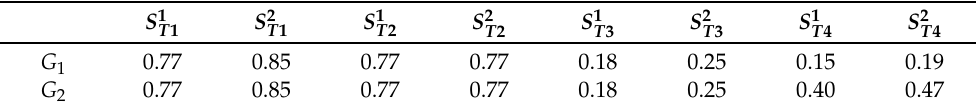
Table A1. Coherence of the CORE-clusters tested Appendix A on G 1 and G 2 . Corresponding representative variables are given Table A2.